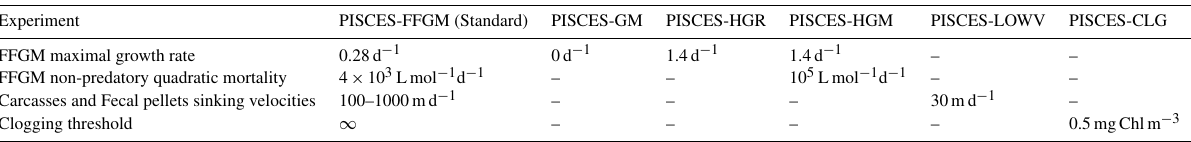
Table 3. Sensitivity experiments parameterization. A dash indicates that the parameter value is the same as in the standard PISCES-FFGM